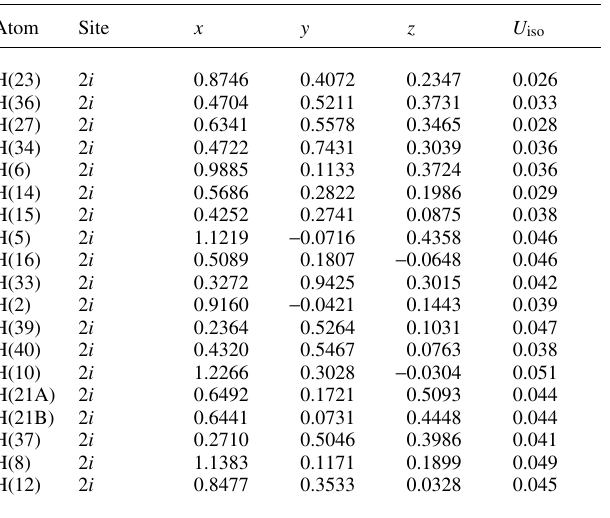
Table 2. Atomic coordinates and displacement parameters (in Å 2 )